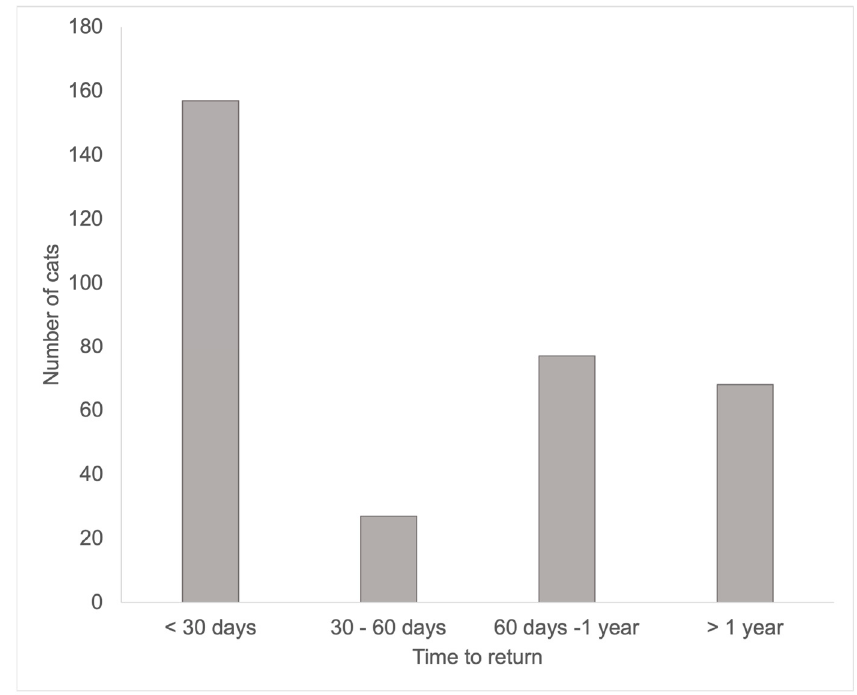
Figure 1. Number of cats returned to the shelter over time. Table 1. Relative risk of different outcomes following a return in the short term (<30 days) and long term (>30 days). Bold indicates significant at the p < 0.05 level.